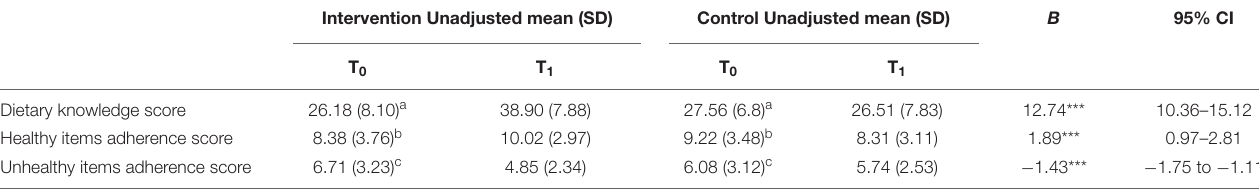
TABLE 2 | Means and standard deviations (SD) of the total dietary knowledge score, healthy items score, and unhealthy items score and the intervention effect on the three scores. Intervention Unadjusted mean (SD)